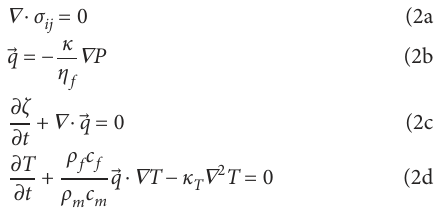
such as melt injection in the base of the crystal mush; a top- down propagation is relevant to scenarios such as eruption of a melt lens above a mush column/layer. In the current model, the bottom-up transport and top-down transport are independent from each other, but are shown in the same figures in both the cartoon and the result section for convenience. Lithospheric stresses and gravitationaleffectareassumedtoonlycontributetothebackground state and do not influence the transport of melts, pressure and temperature